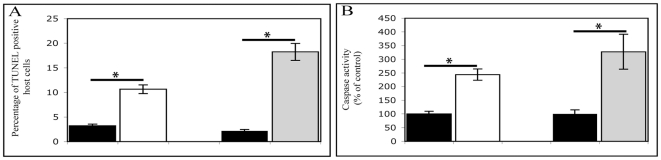
Quantification of apoptosis-like activity in Acropora millepora.Apoptosis-like activity measured as TUNEL positive cells and caspase 3-like activity within the host tissue of A. millepora incubated in control (black), colchicine (white) and fast heat stress (grey). (A) The percentage of TUNEL-positive host cells was measured in thin sections of coral tissues obtained from 6 coral branches (6 sections were analysed and averaged per coral branch), for each treatment and each time point. TUNEL-labelled host cells were counted in an image field (×40 magnification) and compared with the entire population of host cells in the same image field to derive the percentage of the TUNEL-positive population. A total of three image fields per tissue section was analysed and averaged. (B) The caspase 3-like activity assay was performed on A. millepora host tissue extract and is expressed as percentage of control. Error bars represent ± SEM, (N = 3 coral branches for caspase 3-like activity; N = 6 coral branches for TUNEL staining). * t- test in comparison to control, P<0.05.